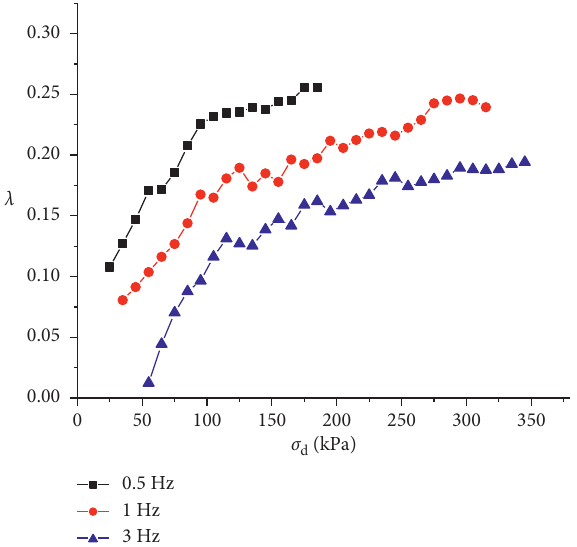
Figure 11: Damping ratio versus dynamic stress amplitude curves at different